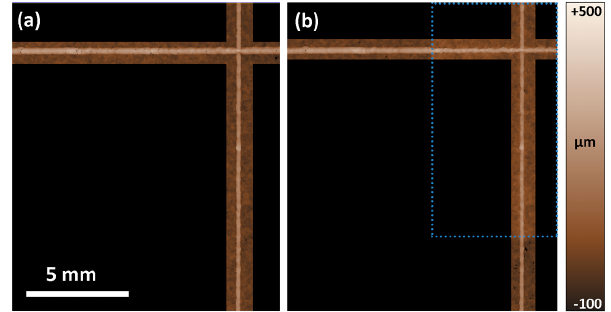
Figure 8. Topography of the cladded type K thermocouple ( a ) before and ( b ) after embedding.